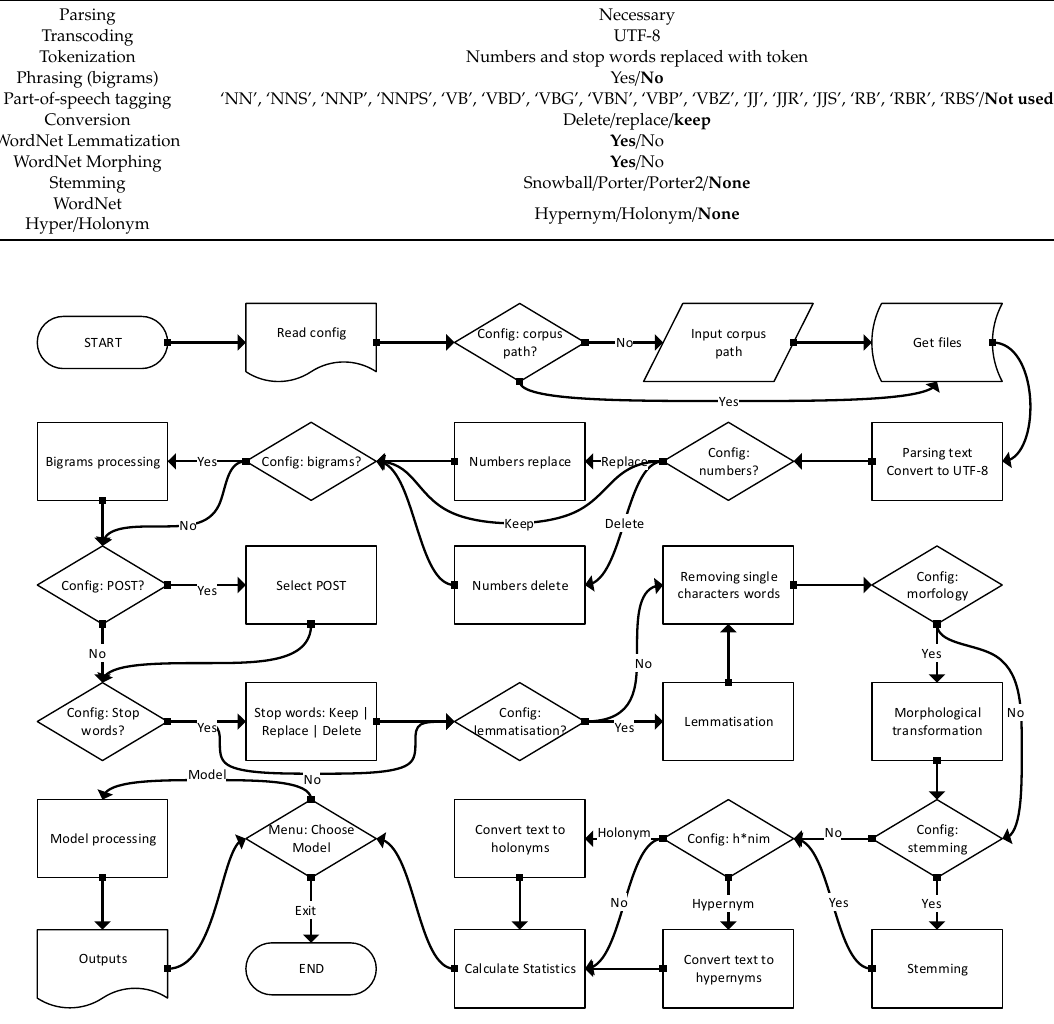
Figure 4. Text processing flowchart.